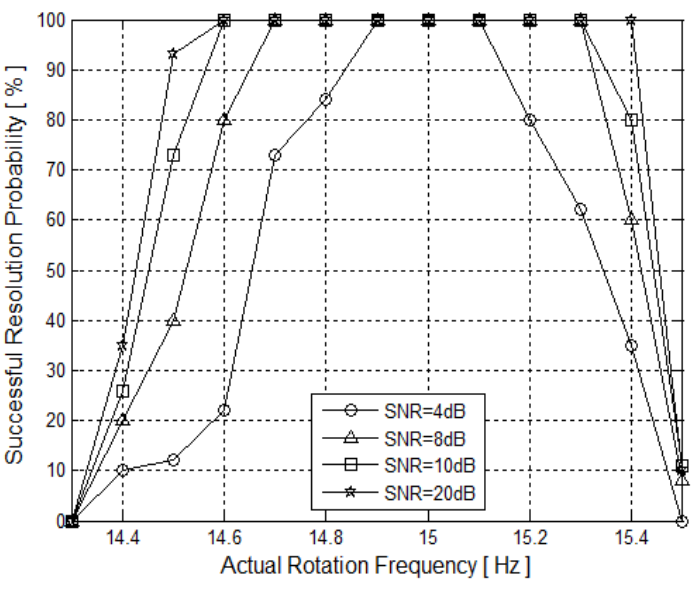
Figure 9. Successful resolution probability versus rotation frequency